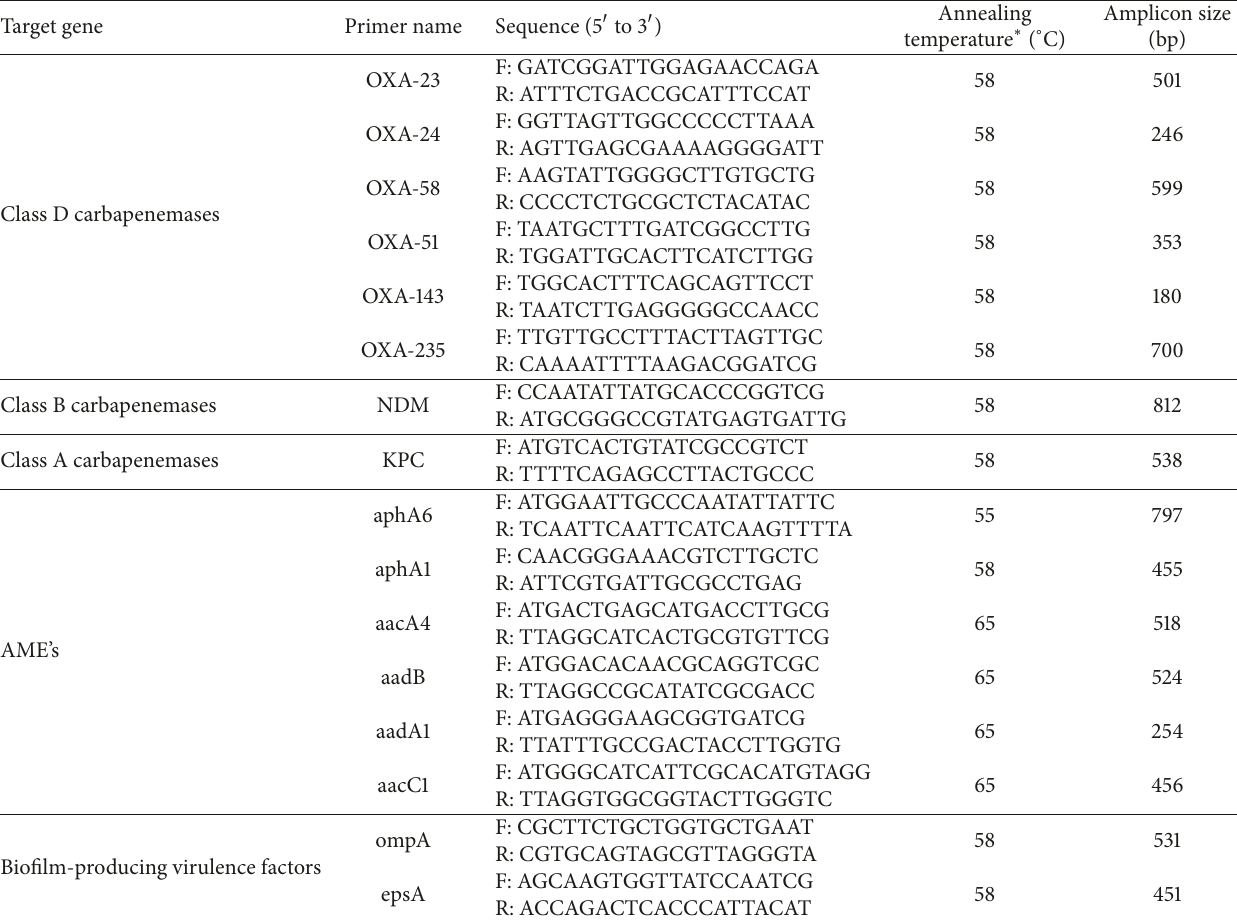
Table 1: Summary of the target genes screened for using polymerase chain reaction